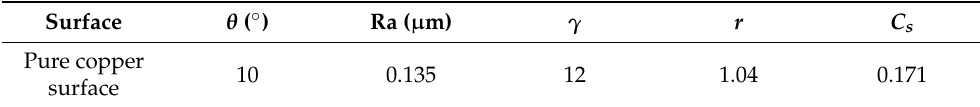
Figure 2. Scheme of the proposed cooling system:(a) Whole of experimental apparatus; (b) inside of experimental apparatus; (c) CPU; (d) placement of the thermocouple;. Table 1. Comprehensive influence parameters of heating